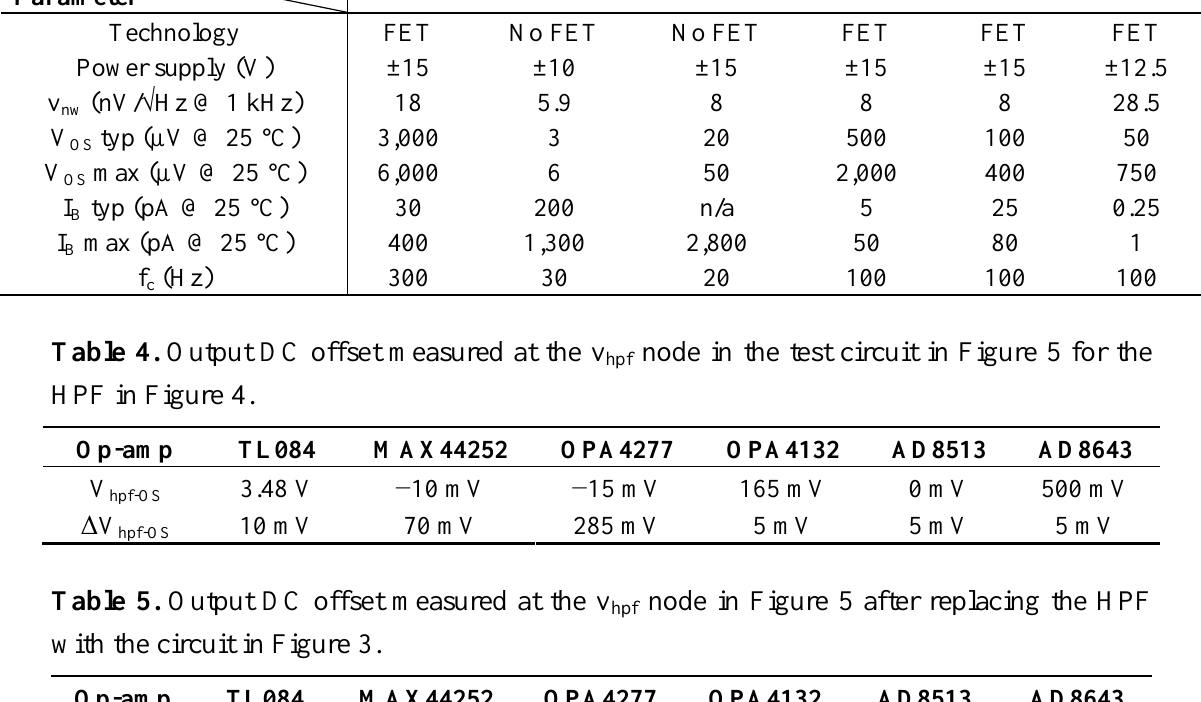
Table 3. Manufacturer specifications for the op-amps in trial. n/a: not available.